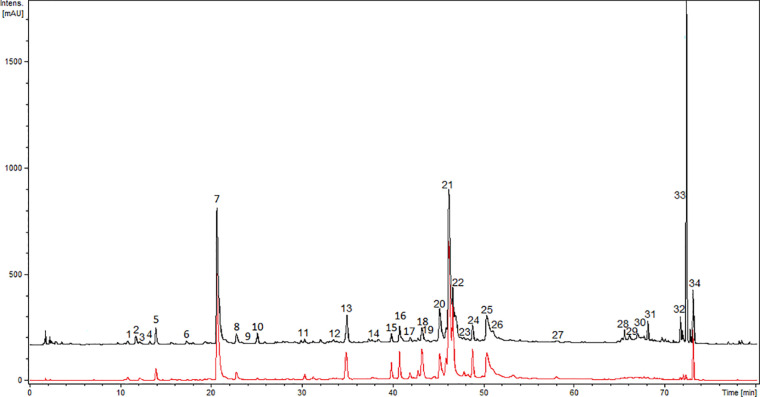
UHPLC-DAD-ESI-MS/MS chromatograms of ADI recorded at 280 nm (black line) and 350 nm (red line).